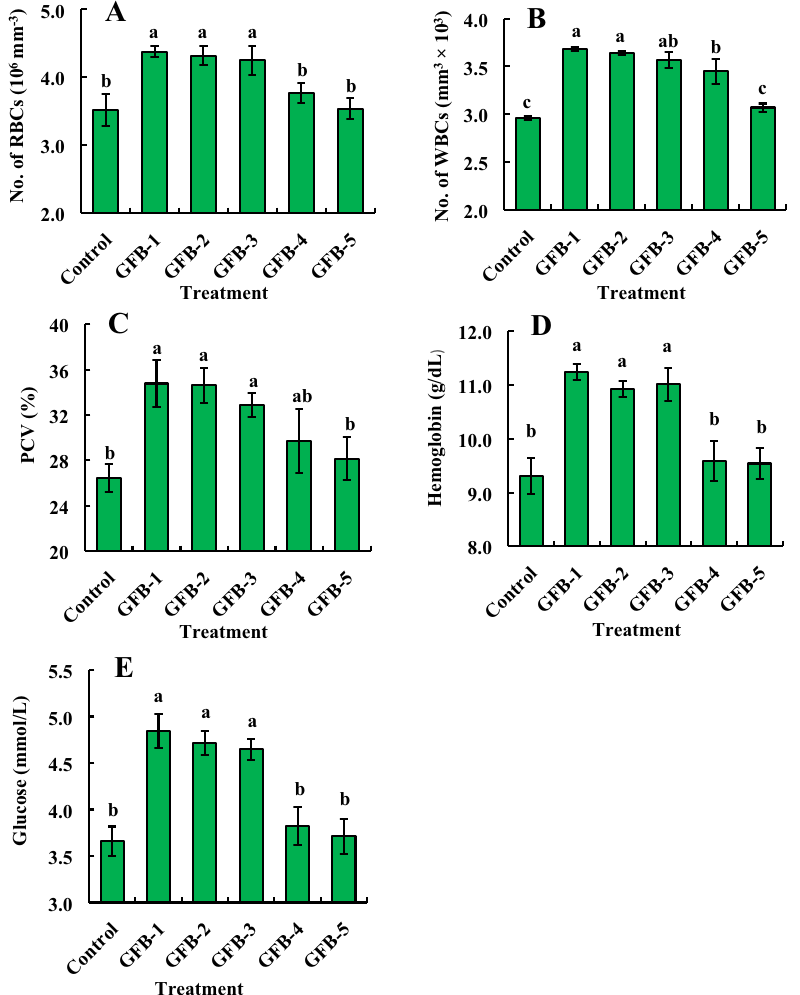
3.03.54.04.55.05.5 Figure 8. Assessment of individual effects of five isolated probiotic strains viz . GFB-1, GFB-2, GFB-3, GFB-4 and GFB-5 from the gut of B. gonionotus on hematological parameters (A, B, C, D and E) of the host fish. Blood was collected from ten fishes of each replication for estimating red blood cell (RBC), white blood cell (WBC), packed cell volume (PCV), hemoglobin level and glucose level. One way ANOVA was performed for analyzing the data of three replicated experiment and data in column varies significantly in LSD at P < 0.05 (Statistix 10). Different letter bars indicate significant variations in RBC, WBC, PCV (%), hemoglobin and glucose of the host fish in different groups by the isolates at P < 0.05 (Statistix 10). Error bar = ± SD; n = 27. R 2 values are as follows: RBC = Control (0.848), GFB-1 (0.921), GFB-2 (0.999), GFB-3 (0.993), GFB-4 (0.971), and GFB-5 (0.969); WBC = Control (0.912), GFB-1 (0.824), GFB-2 (0.892), GFB-3 (0.692), GFB-4 (0.997), and GFB-5 (0.951); PCV = Control (0.745), GFB-1 (0.713), GFB-2 (0.623), GFB-3 (0.822), GFB-4 (0.907), and GFB-5 (0.644); Hemoglobin = Control (0.978), GFB-1 (0.714), GFB-2 (0.644), GFB-3 (0.979), GFB-4 (0.678), and GFB-5 (0.749); Glucose = Control (0.957), GFB-1 (0.714), GFB-2 (0.669), GFB-3 (0.956), GFB-4 (0.520), and GFB-5 The effects of five gut bacterial iso- lates on the digestive enzyme activities were determined to evaluate their feasibility as probiotic candidates (Table 2). In this study, all five bacterial isolates enhanced protease and lipase activities. Among the bacterial iso- lates, significantly ( P < 0.05) the highest protease activities were demonstrated by GFB-3 (8.60 ± 0.61 µg ml −1 h) followed by GFB-1 (8.43 ± 0.41 µg ml −1 h) and GFB-4 (7.60 ± 0.49 µg ml −1 h) (Table 2). Significantly ( P < 0.05) the highest lipase activity was shown by the isolate GFB-1 (1.43 ± 0.03 µmol fatty acid ml −1 ) followed by GFB-2